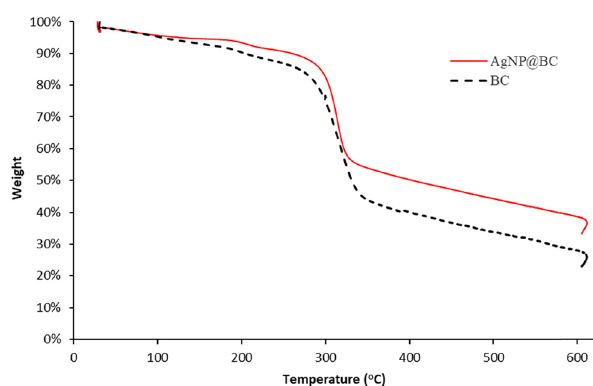
Figure 7: Thermal stability of pristine BC and AgNP10@BC by TGA